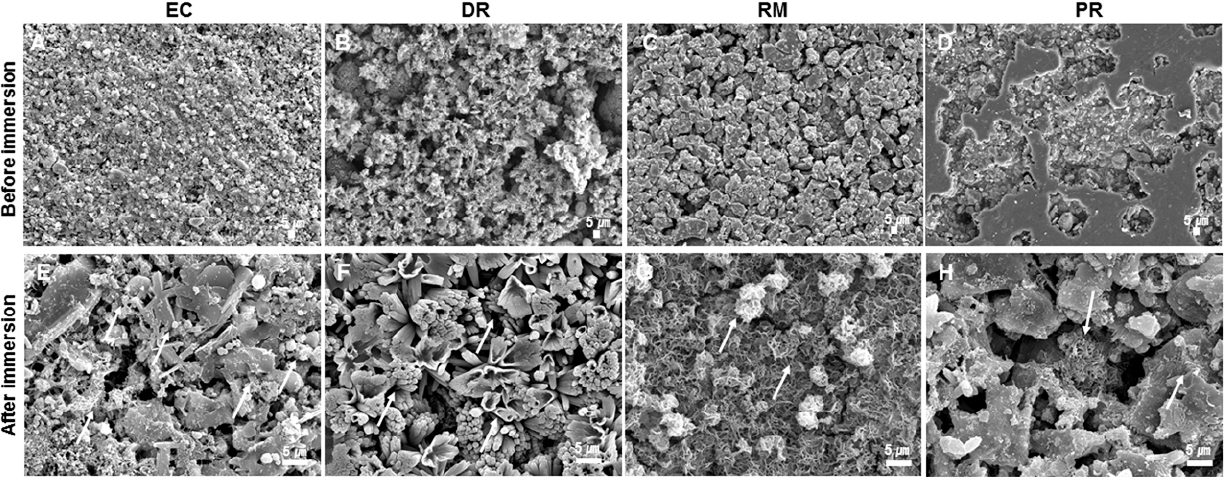
Figure 1. Scanning electron microscopy analysis of ( A ) Endocem MTA (EC), ( B ) Dia-Root Bio MTA (DR), ( C ) Retro MTA (RM), and ( D ) Pro Root MTA (PR) before immersion in Hank’s balanced salt solution (HBSS) (500× magnification). Surface precipitates on sets ( E ) EC, ( F ) DR, ( G ) RM, and ( H ) PR produced after immersion in HBSS for 7 d (2000× magnification). Scale bar represents 5 μ m.